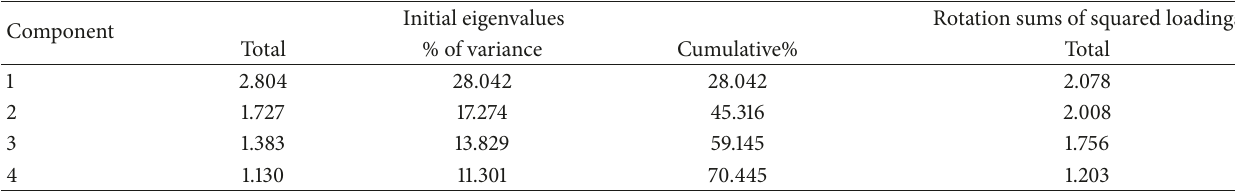
Table 6: Factor analysis intention domain: construct